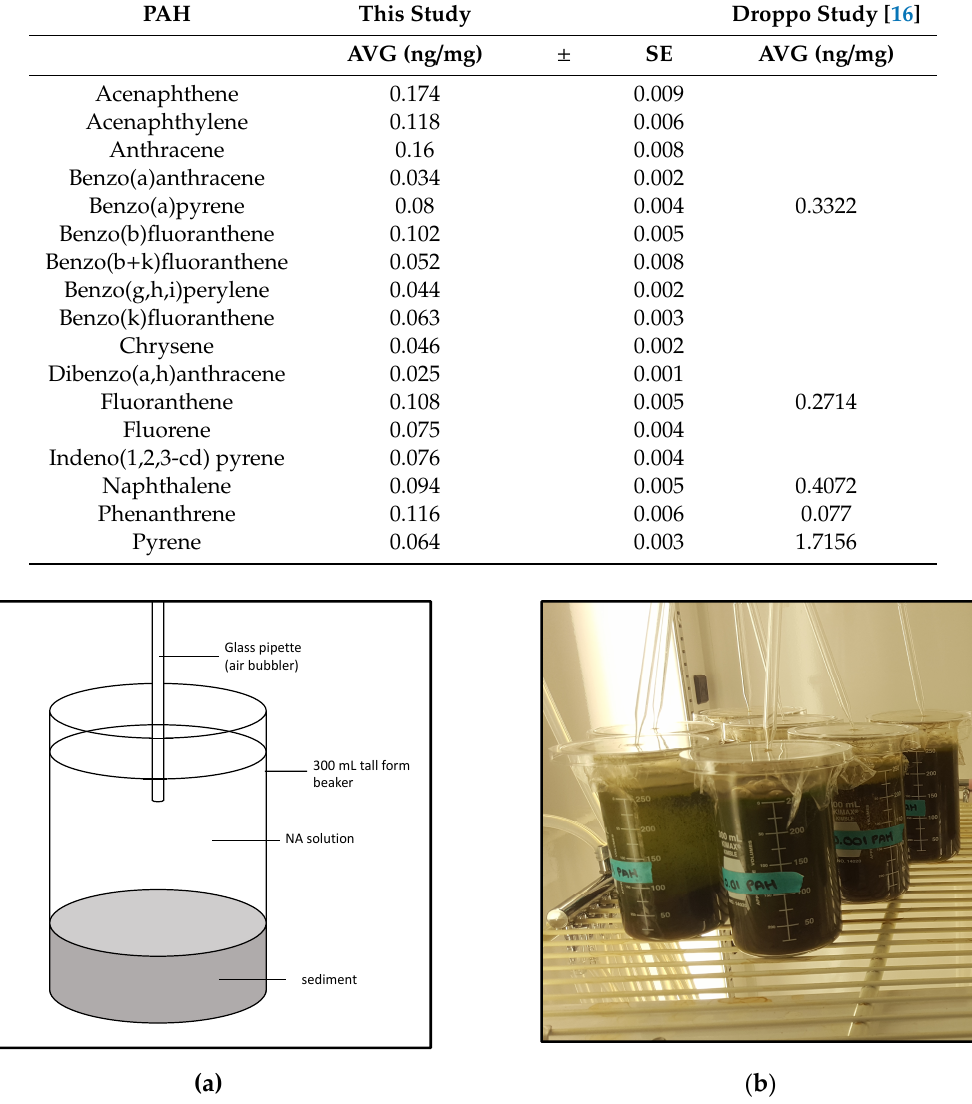
Figure 1. Laboratory setup for 21 day exposure to NA mixture treatments (0, 0.001, 0.1, 1 mg/L) and control sediment or polycyclic aromatic hydrocarbons (PAH)-spiked sediment: ( a ) individual replicate and ( b ) treatment set up in an environmental chamber.